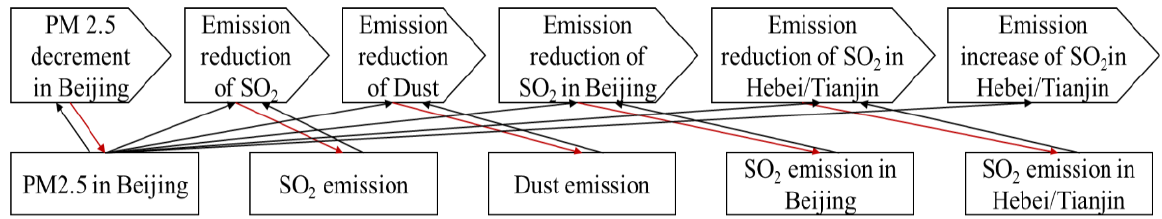
Figure 10. Qualitative analysis bipartite diagram for flow rate controlled by flow level.